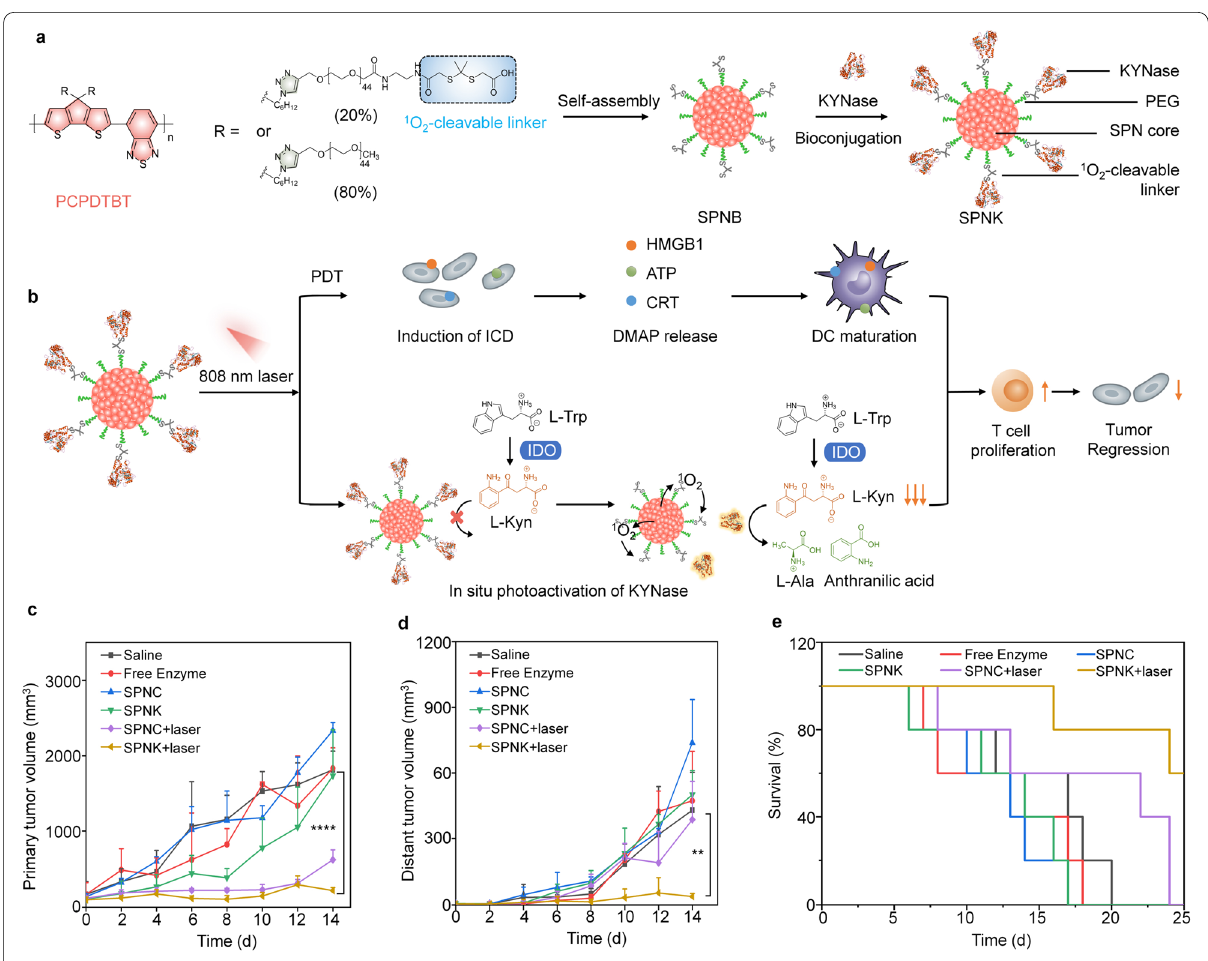
Fig. 8 a Schematic illustration of the preparation procedure of SPNK. b The proposed mechanism of SPNK-mediated synergistic photodynamic immunometabolic therapy. Growth curves of c primary tumors and d distant tumors in B16F10 tumor-bearing mice after different treatments. e Survival curves for the treated and control mice. Reproduced with permission from [99]. Copyright 2021,